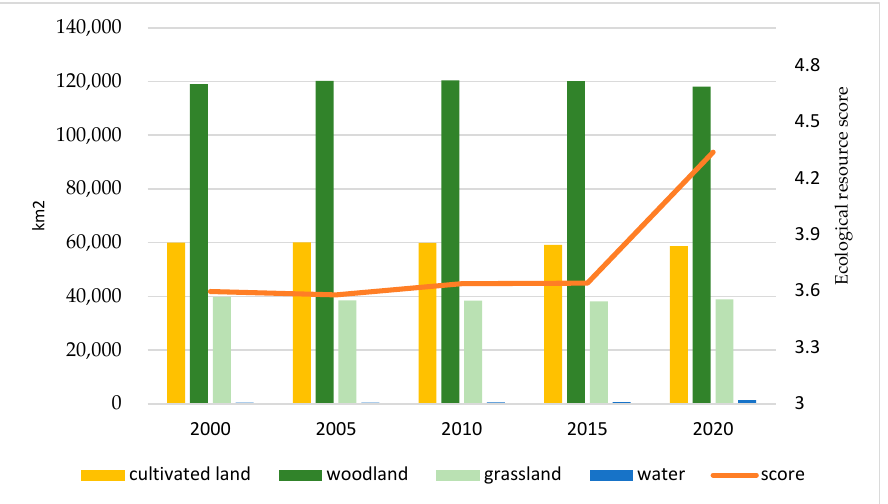
Figure 4. Ecological resource scores for different resources of Guizhou Province from 2000 to 2020.